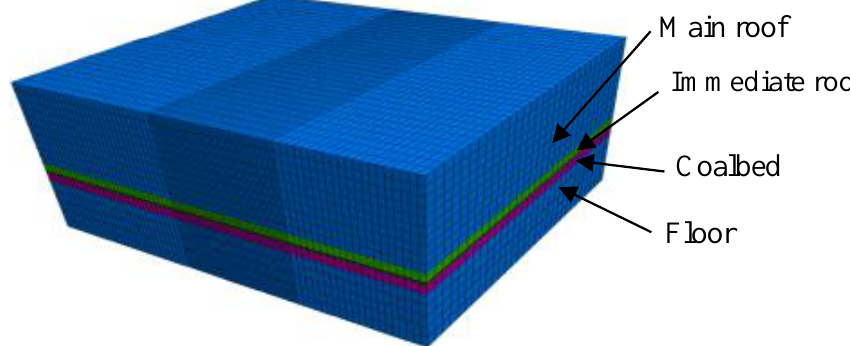
Figure 9. A diagram of a 3D numerical model.